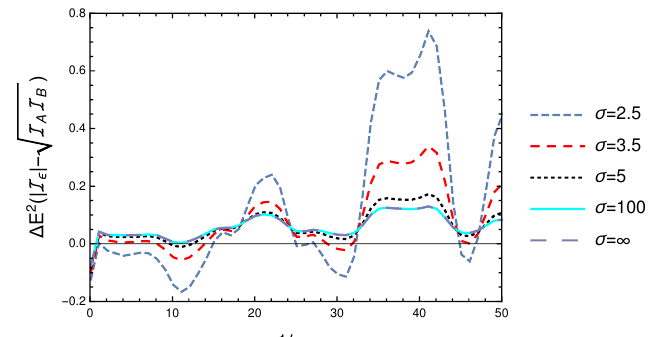
√ (cid:0) (cid:1) is plotted for two anti-parallelly |I ε | − I A I B for different fixed σ . A = 1 . B